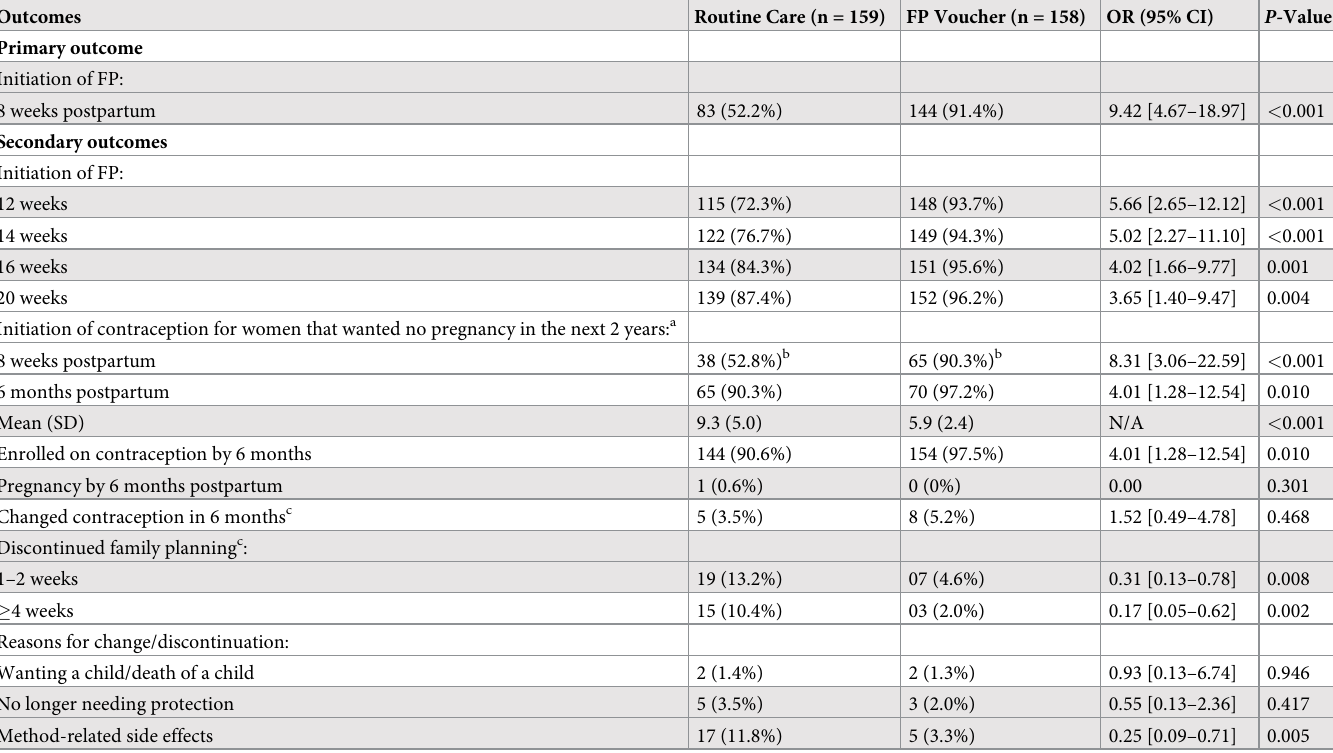
Table 2. Primary and secondary outcomes by treatment